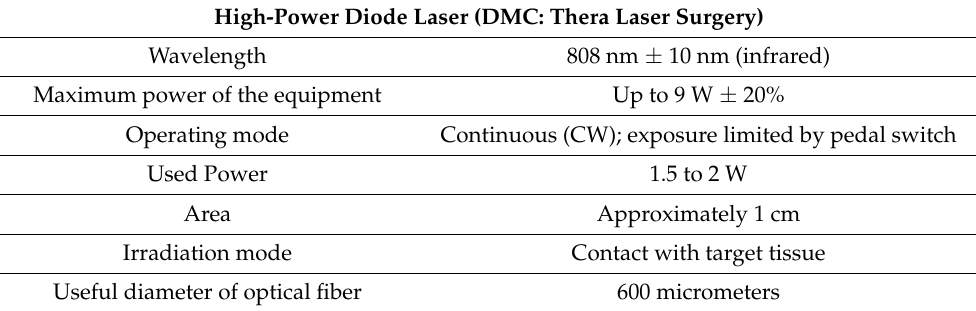
Table 2. Parameters for the high-power diode